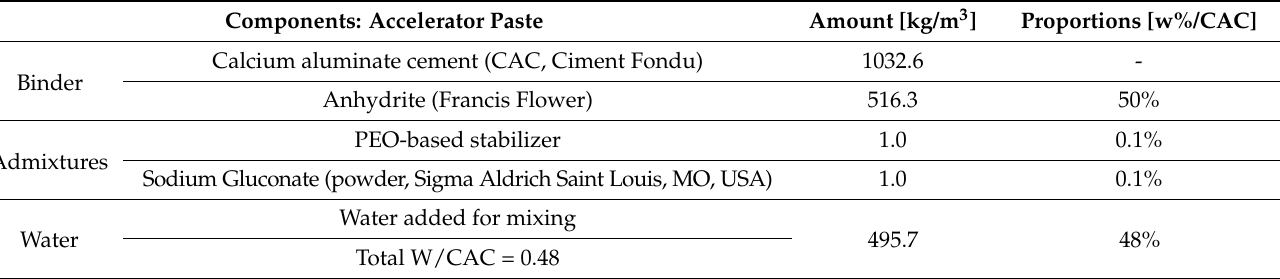
Table 2. Recipe for the accelerator